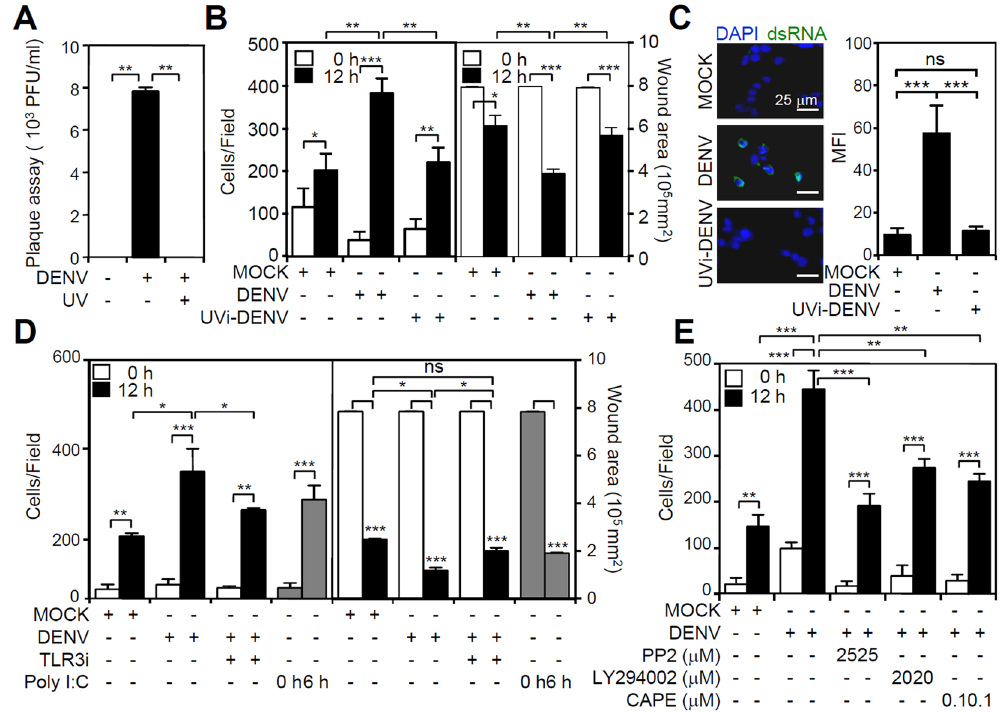
Figure 5. DENV infection increases cell migration through the TLR3/Src-regulated pathway. BV2 cells were inoculated with DENV 2 (MOI = 50) for 12 h in the absence or presence of UV irradiation (UVi). ( A ) The plaque assay confirmed virus release. ( B ) Wound-healing assay-based analysis of cell migration performed using the Image J software based on the number of migrating cells and wound area changes. ( C ) Representative fluorescent immunostaining images and MFI analysis displayed dsRNA replication. Migration in cells incubated with or without ( D ) TLR3 inhibitor (TLR3i, 5 µ M) and ( E ) Src inhibitor (PP2, 25 µ M), PI3K inhibitor (LY294002, 20 µ M), or NF-kB inhibitor (CAPE, 0.1 μ M) treatment was measured by the wound-healing assay 12 h post-infection. Poly(I:C) was used as a positive control for TLR3 activation. The quantitative data are depicted as the means ± SD. * p < 0.05, ** p < 0.01, and *** p < 0.001. ns, not